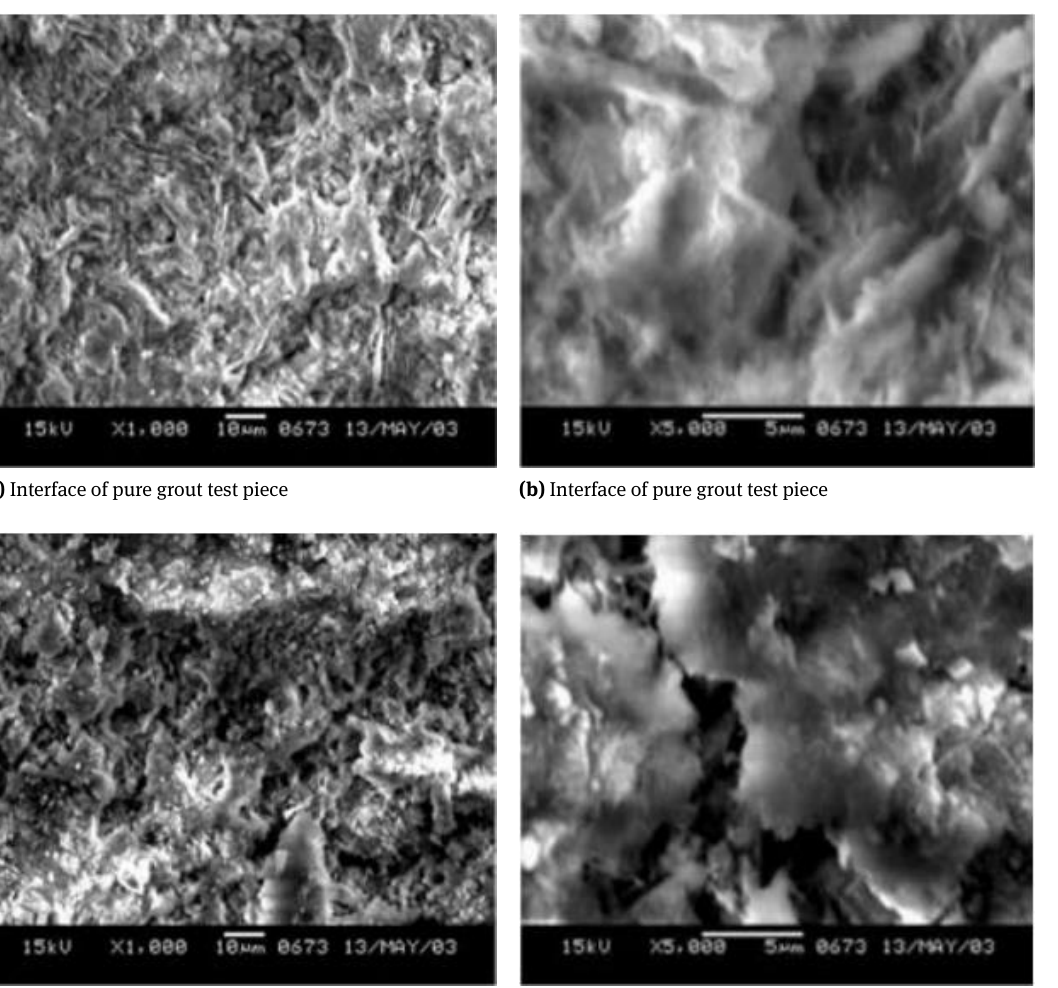
modified carbon fiber concrete increased by 90%, 57% and 77%, respectively, compared to the control concrete.